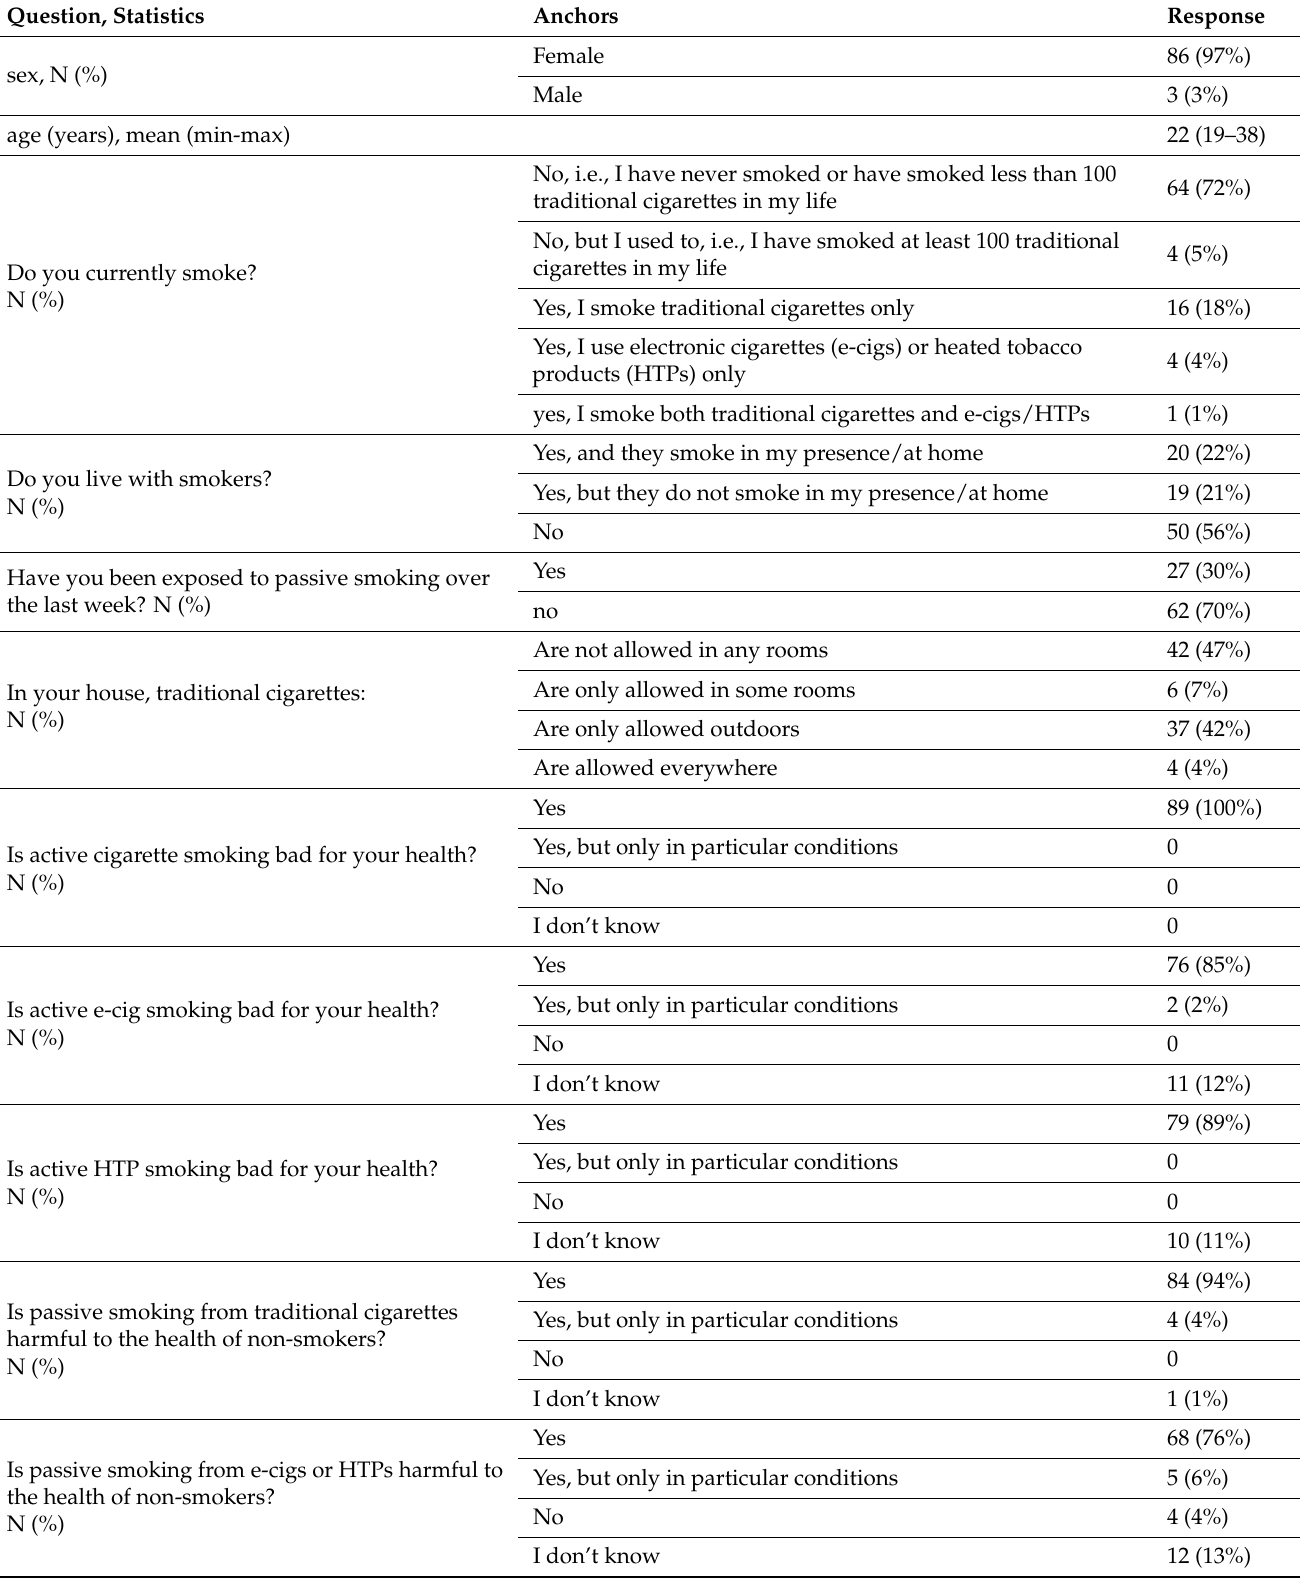
Table 2. Main characteristics of the study participants and the main results of the pilot